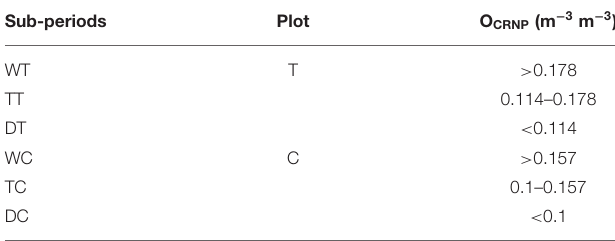
TABLE 2 | Classification according to the water content in the soil.